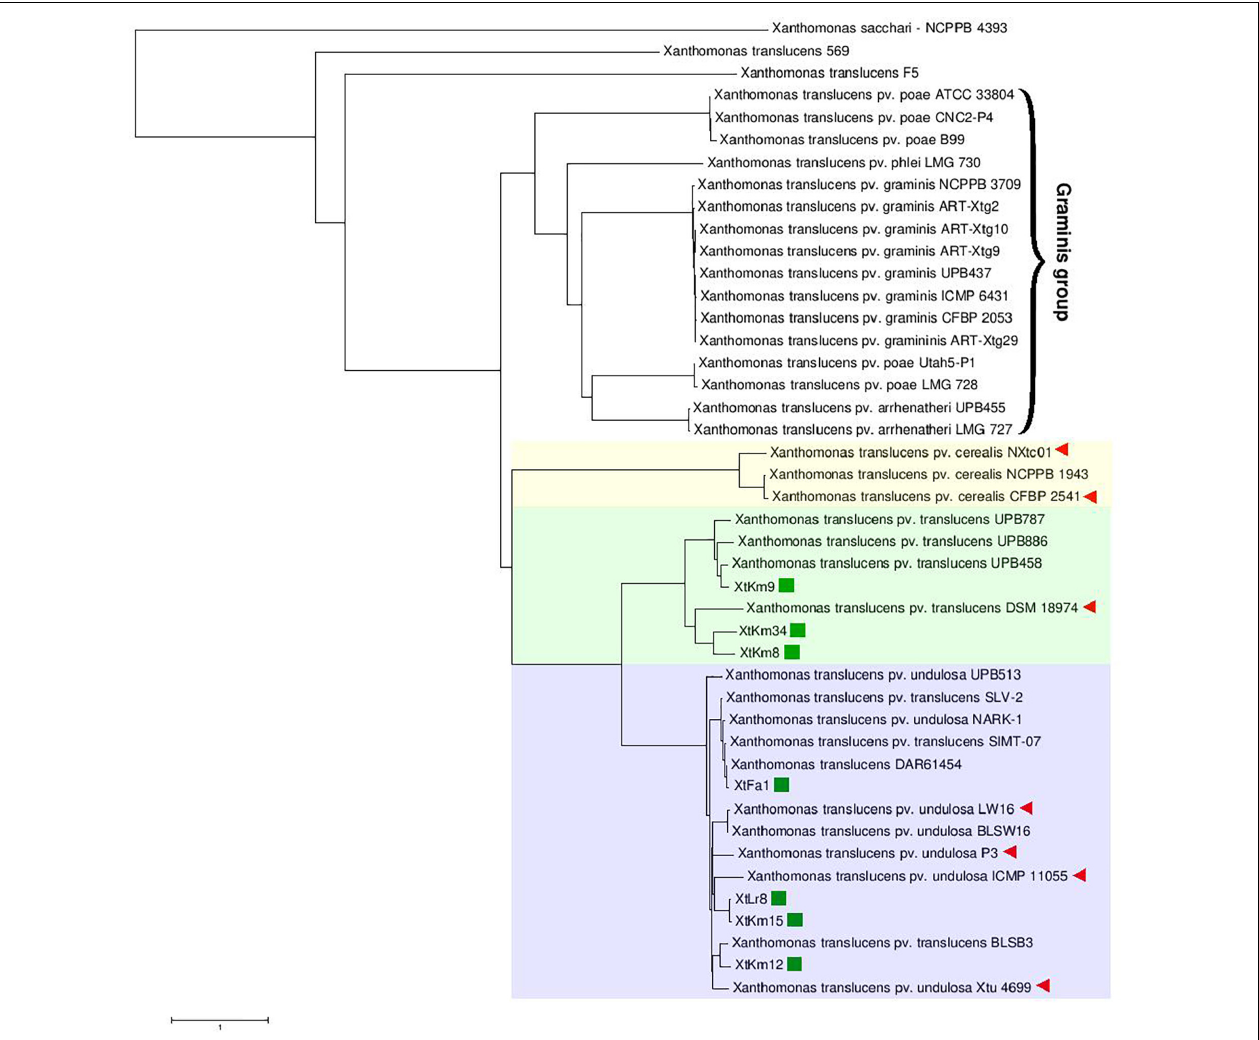
FIGURE 1 | Average Nucleotide Identity (ANI)-based Neighbor-Joining distance clustering plot of all available Xanthomonas translucens strains constructed using the ANI calculator online service. Members of X. translucens were clustered in two phylogenetically distinct clades, i.e., graminis and translucens groups. Among the strains sequenced in this study, XtKm8, XtKm9, and XtKm34 clustered within the X. translucens pv. translucens clade while the strains XtFa1, XtLr8, XtKm12, and XtKm15 clustered in the X. translucens pv. undulosa clade. Three strains, i.e., SLV-2, SIMT-07, and BLSB3 that labeled as X. translucens pv. translucens in the NCBI GenBank database were clustered within the X. translucens pv. undulosa strains indicating a mislabeling in the identification of these strains. Based on the ANI values, the strains 569 and F5 could not be included within X. translucens , where the ANI values between these two strains and the other members of the species were consistently below